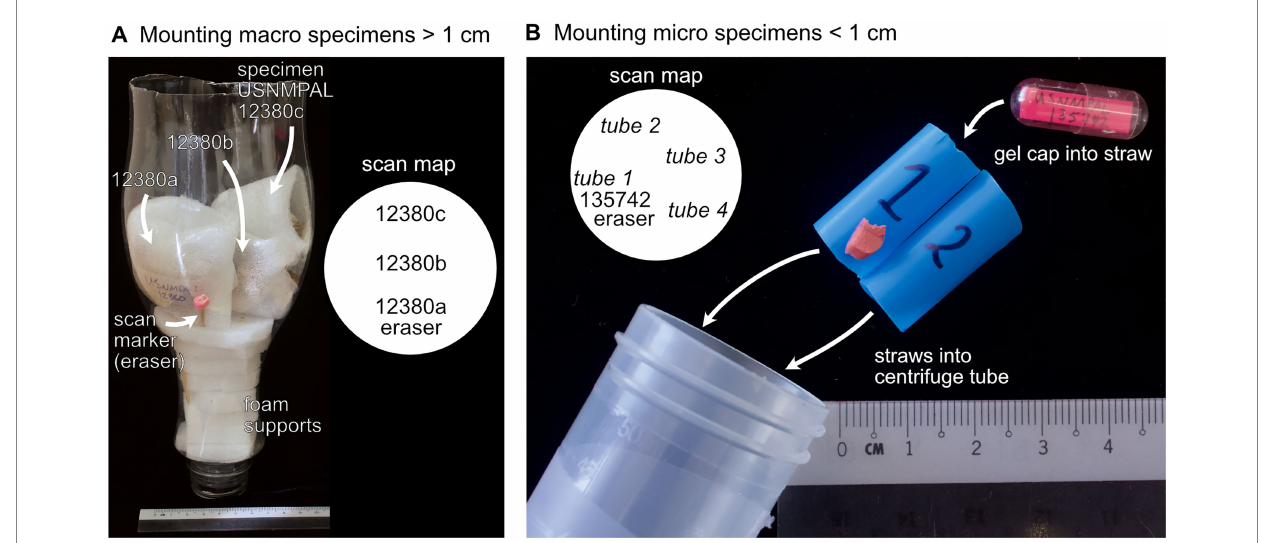
FIGURE 2 Mount of specimens for micro-CT imaging. (A) Macro specimens (>1 cm) are placed inside a cylindrical plastic container in an imbricated manner, with commissures perpendicular to the foam support at the base of the container. The scan map records the position of specimens in the scan mount using registration numbers or unique specimen IDs relative to the scan marker (e.g., an eraser). (B) Micro specimens (<1 cm) are placed inside plastic or paper straws, which are then placed inside a 15 ml or 50 ml centrifuge